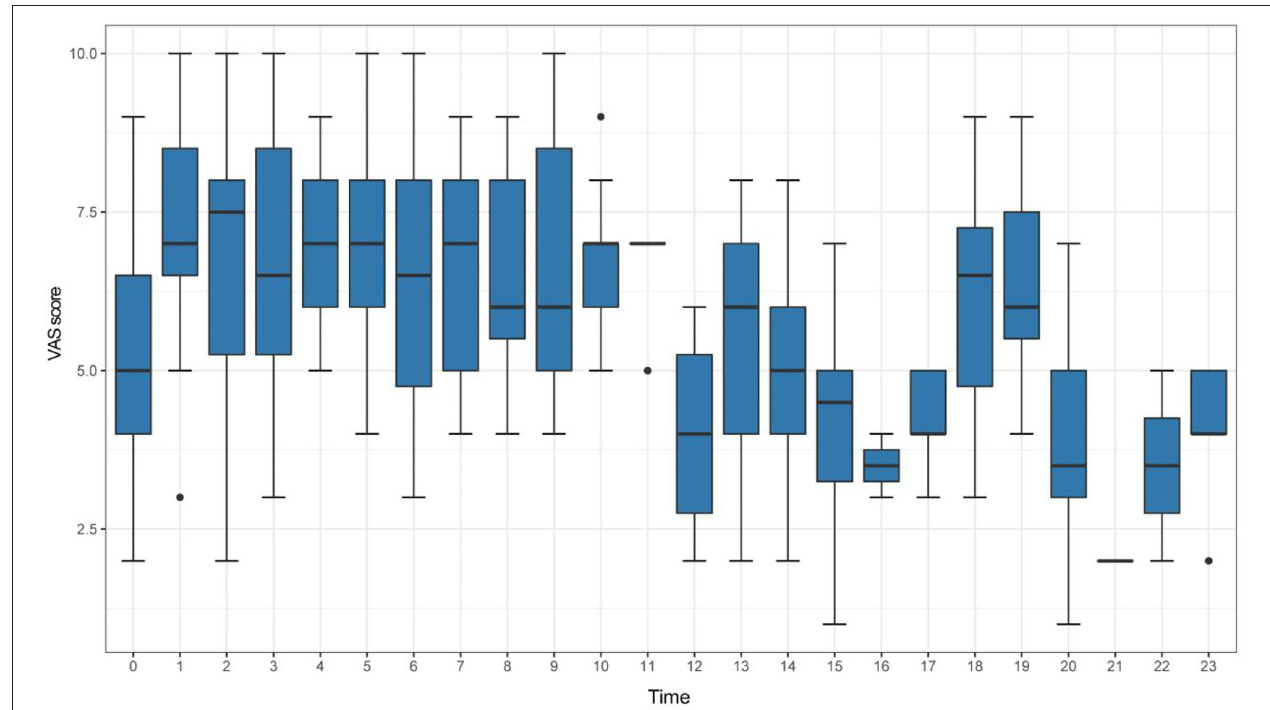
FIGURE 2 | Box plots for time and VAS scores in VM